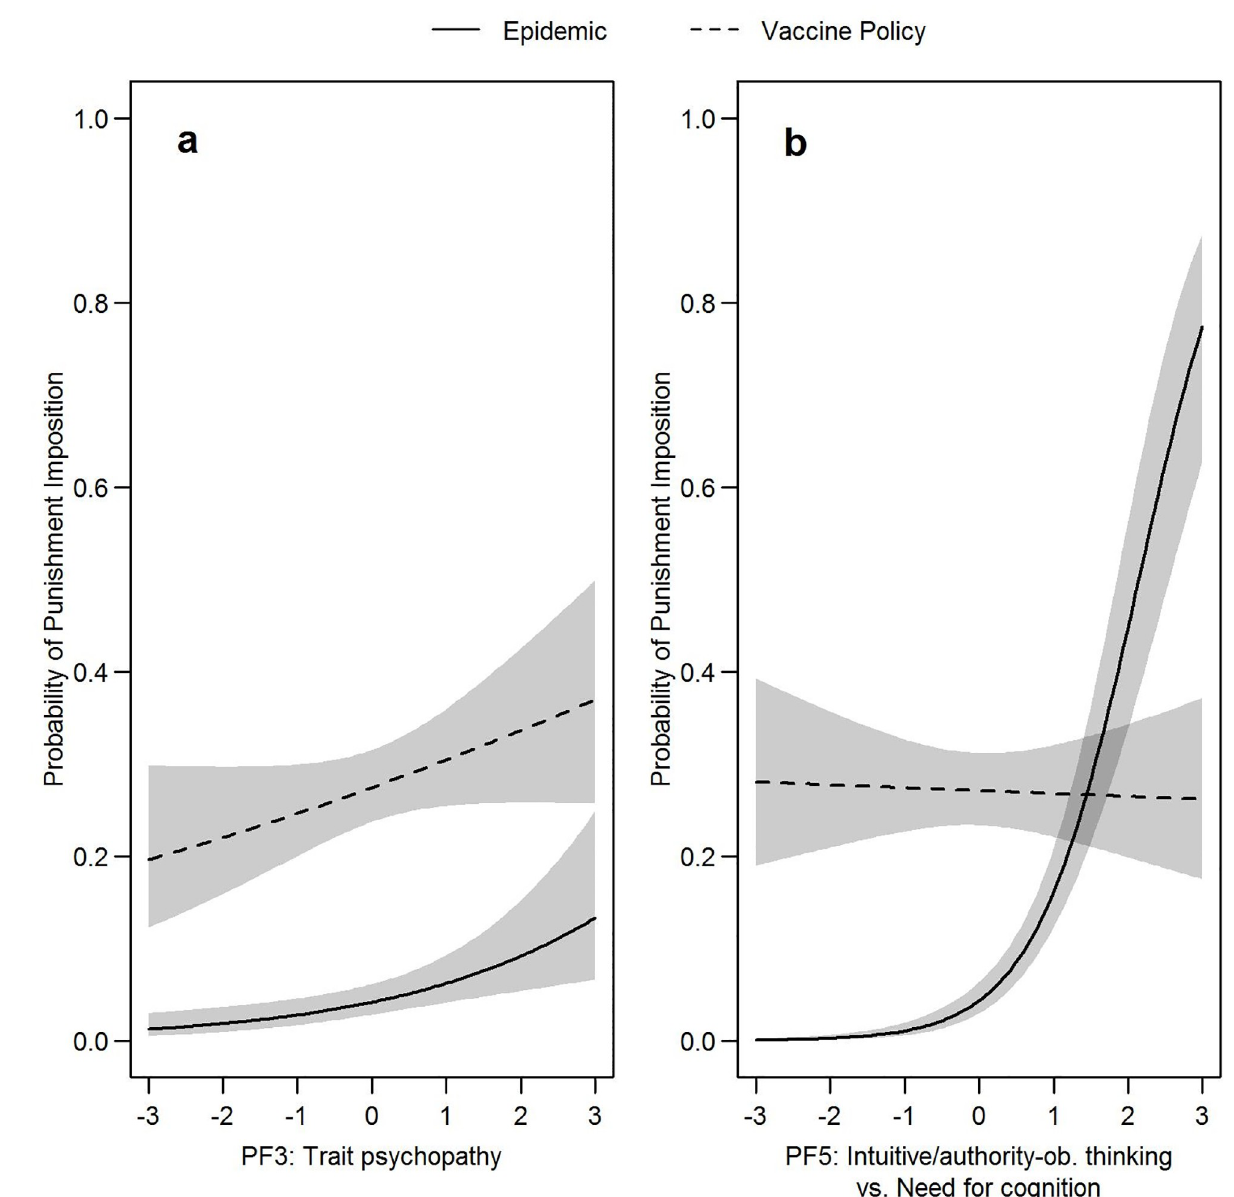
Fig 1. Visualization of the results of the mixed logistic regression. Trend lines illustrate the predicted probability of punishment imposition in the two scenarios epidemic (deliberate harm) and vaccine policy (accidental harm) depending on observers’ personality differences. Shaded areas represent 95% confidence